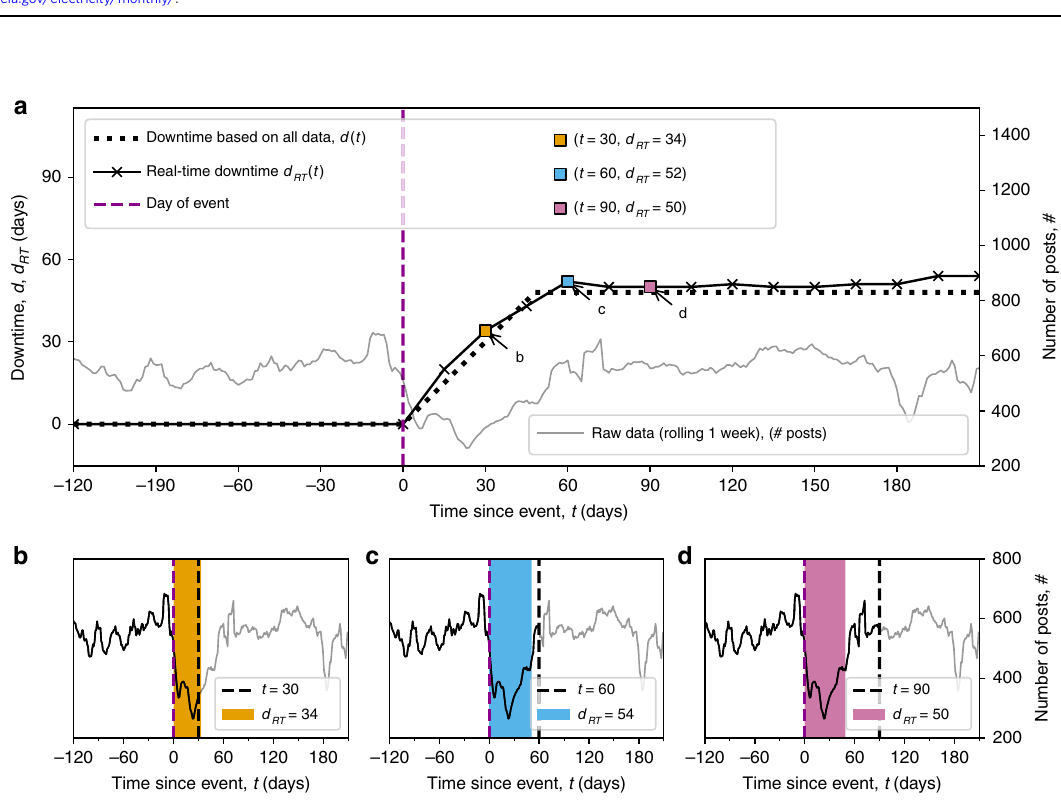
Fig. 5 Downtime detection in real-time ( d RT ( t )) for Kathmandu, Nepal. a Data are cropped at regular intervals to simulate real-time data collection (crossed markers along solid line). Square markers at ð t ; d RT ð t ÞÞ indicate the real-time estimates for data cropped at t ¼ 30, 60, 90 days. Dotted line indicates the ideal downtime, d ð t Þ , estimated using all data. b – d Black solid lines denote the cropped data used to estimate downtime at t ¼ 30, 60, 90 days after the event (dashed magenta line) respectively. The cutoff t is shown with a black dashed line. The estimated downtimes d RT ð t Þ are shown with coloured